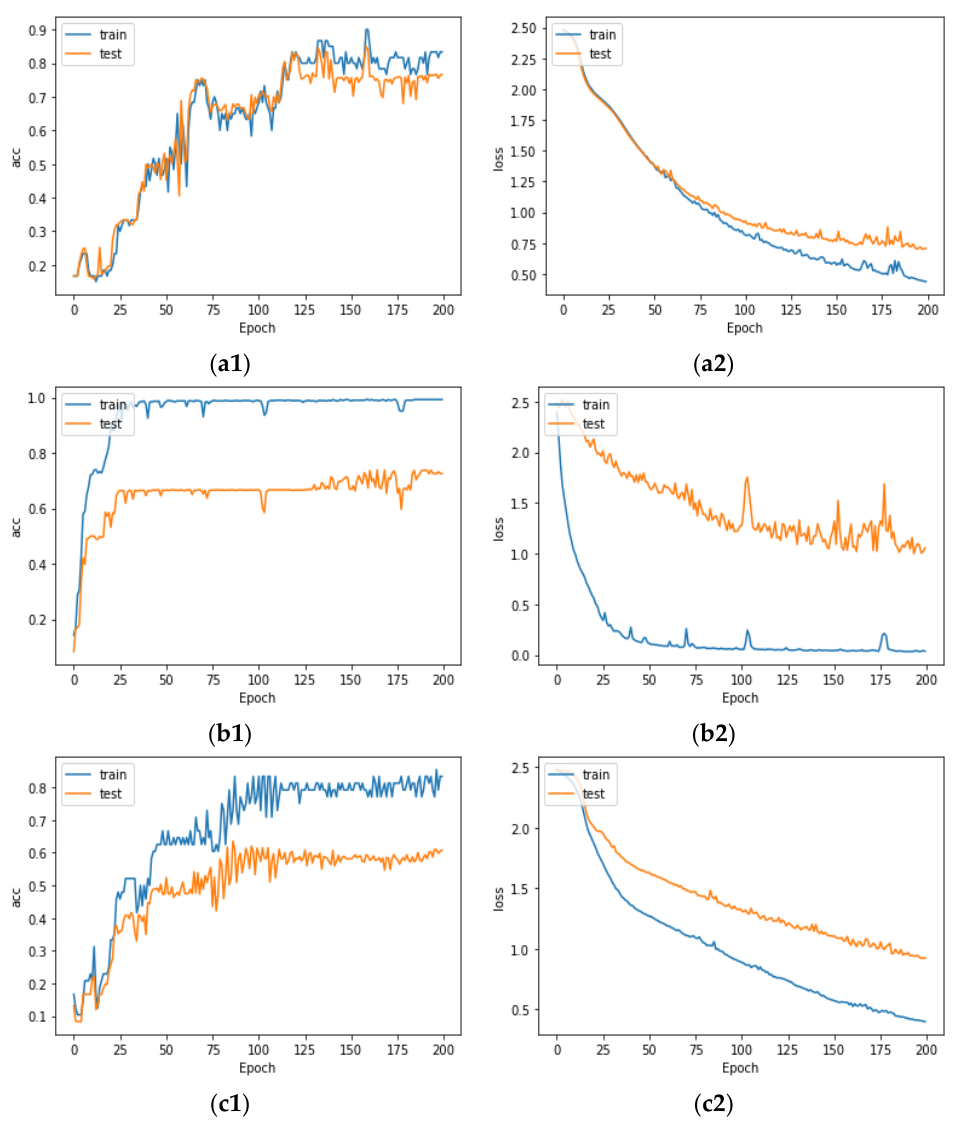
Figure 1. Accuracy and loss curves in classification network training. ( a1 ) Accuracy curve under the insufficient amount condition; ( a2 ) loss curves under the insufficient amount condition; ( b1 ) accuracy curve under the categories missing condition; ( b2 ) loss curve under the categories missing condition; ( c1 ) accuracy curve under the insufficient amount and categories missing condition; ( c2 ) loss curve under the insufficient amount and categories missing condition.